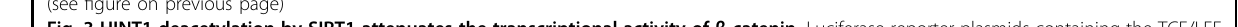
Fig. 3 HINT1 deacetylation by SIRT1 attenuates the transcriptional activity of β -catenin. Luciferase reporter plasmids containing the TCF/LEF binding sequence (TOP/FLASH) were cotransfected into HEK293T cells with several vectors, as indicated. The relative transcriptional activity was determined by the dual luciferase reporter assay. The FOP/FLASH construct was used as a negative control. a Cotransfection with HA- β -catenin, Flag- HINT1, HA-SIRT1 WT, or HY. b Cotransfection with HA- β -catenin, HA-CBP, Flag-HINT1 WT, or 2KR. c HA- β -catenin and Flag-HINT1 WT or 2KR were coexpressed in control (shCON) or SIRT1 (shSIRT1) knockdown cells. d Cotransfection with HA- β -catenin, HA-SIRT1 WT, Flag-HINT1 WT or 2KR. e – j Flag-HINT1 WT or 2KR was transfected into DLD1, RKO, or SW480 cells, followed by quantitative real-time PCR (qRT-PCR) to determine the